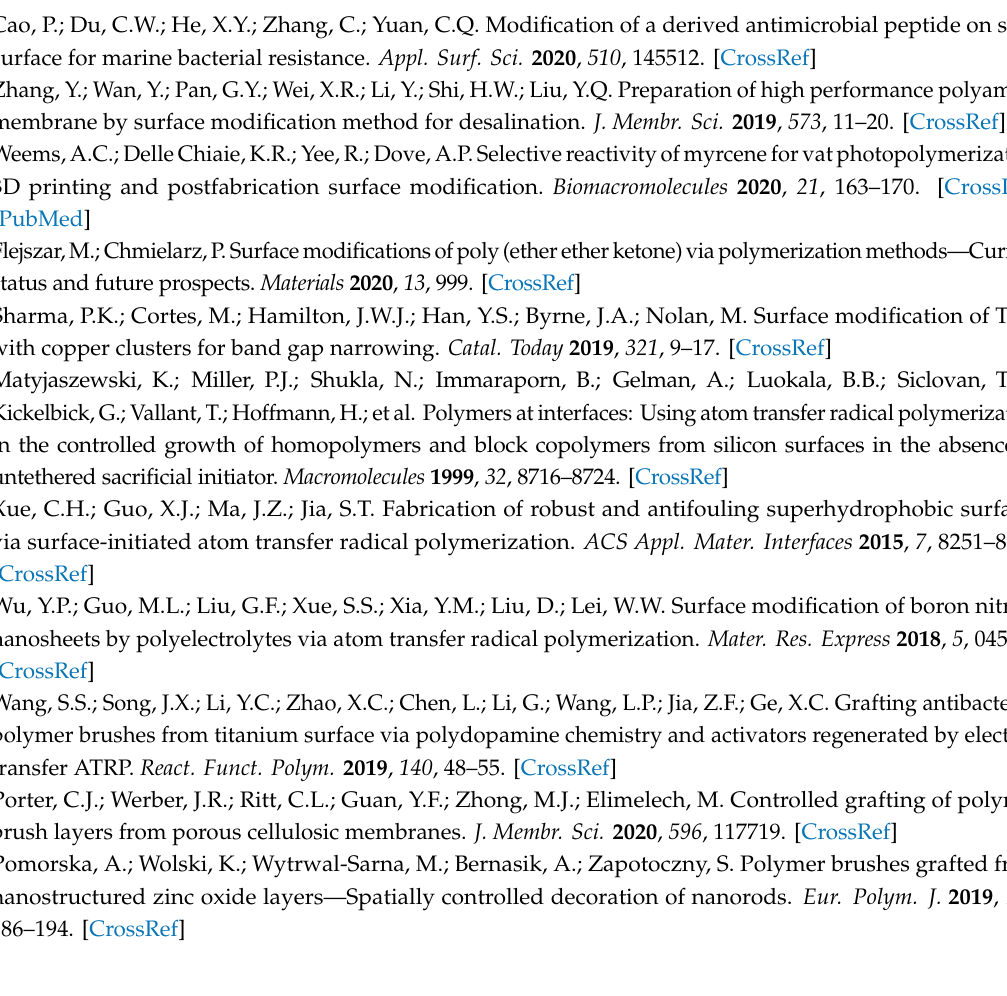
Table S2: Theoretical Al 3 + concentration in solution and polymer by monomer conversion. Table S3: Calculation of Cu I / Cu II ratio for the preparation of polyacrylate brushes. Table S4: Calculation of the Dead Chain Fraction (DCF). Table S5: Experimental values of contact angles for synthesized polymer brushes and brominated silica wafer. Table S6: Parameters of free surface energy (FSE) as calculated by Owens–Wendt and van Oss–Good methods for synthesized polymer brushes and brominated silica